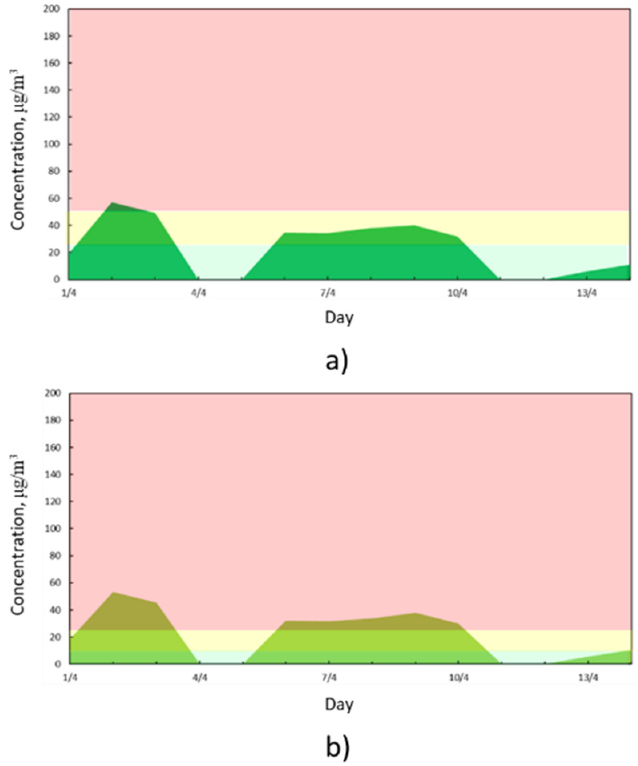
Figure 14. ( a ) PM10 daily average concentration for NIL 23—Lambrate measured in April 2020 from the ROM network in Milan. ( b ) PM2.5 daily average concentration for NIL 23—Lambrate measured in April 2020 from the ROM network in Milan.